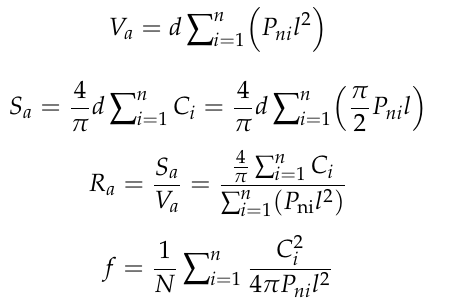
Figure 6. Schematic diagram of effective grid point counting.